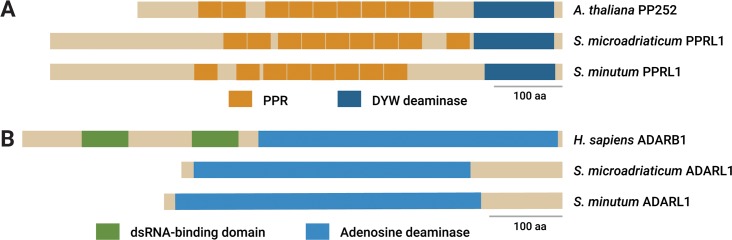
Protein domains of known RNA editing genes and candidate Symbiodinium homologues.For brevity, one representative sequence was chosen per species for (A) PPR-like and (B) ADAR-like proteins.